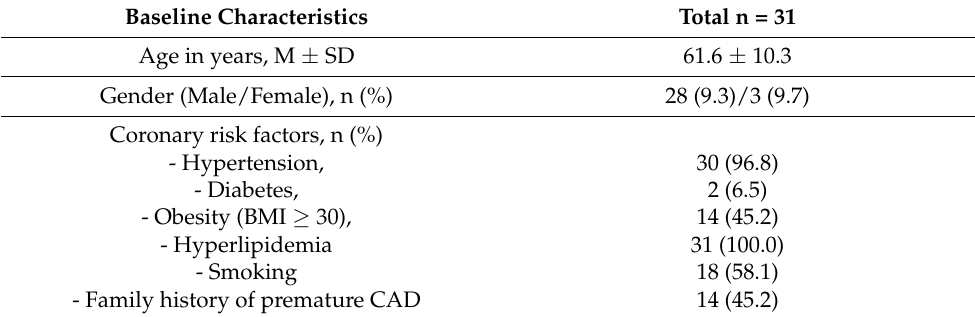
Table 1. Baseline